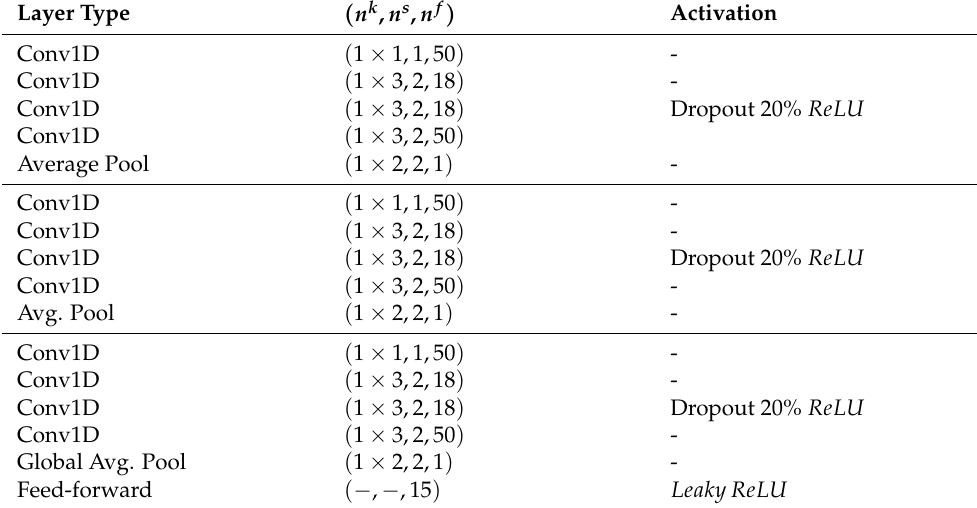
Table 3. Details on temporal CNN which acts as the node-function φ u 0 of the graph independent GN enc GraphNet. n k , n s , n f corresponds to kernel size, stride and number of filters. For dense layers n f corresponds to the layer